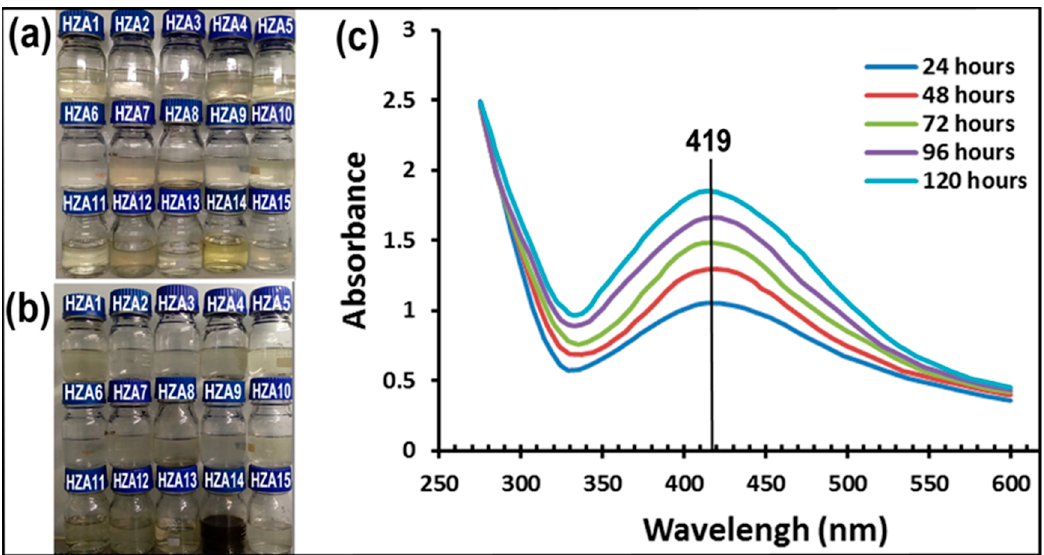
Figure 1. Biosynthesis of AgNPs using 15 Trichoderma spp. isolates and UV ‐ Visible spectra of synthetic AgNPs using cell ‐ free filtrate of T. virens HZA14: ( a ) Cell ‐ free filtrate produced by Trichoderma spp. isolates in different bottles; ( b ) Synthetic AgNPs suspensions in different bottles after 120 h of incubation. The dark brown suspension in a bottle shows the formation of AgNPs; ( c ) UV ‐ Visible spectra of synthetic AgNPs after different times of incubation.